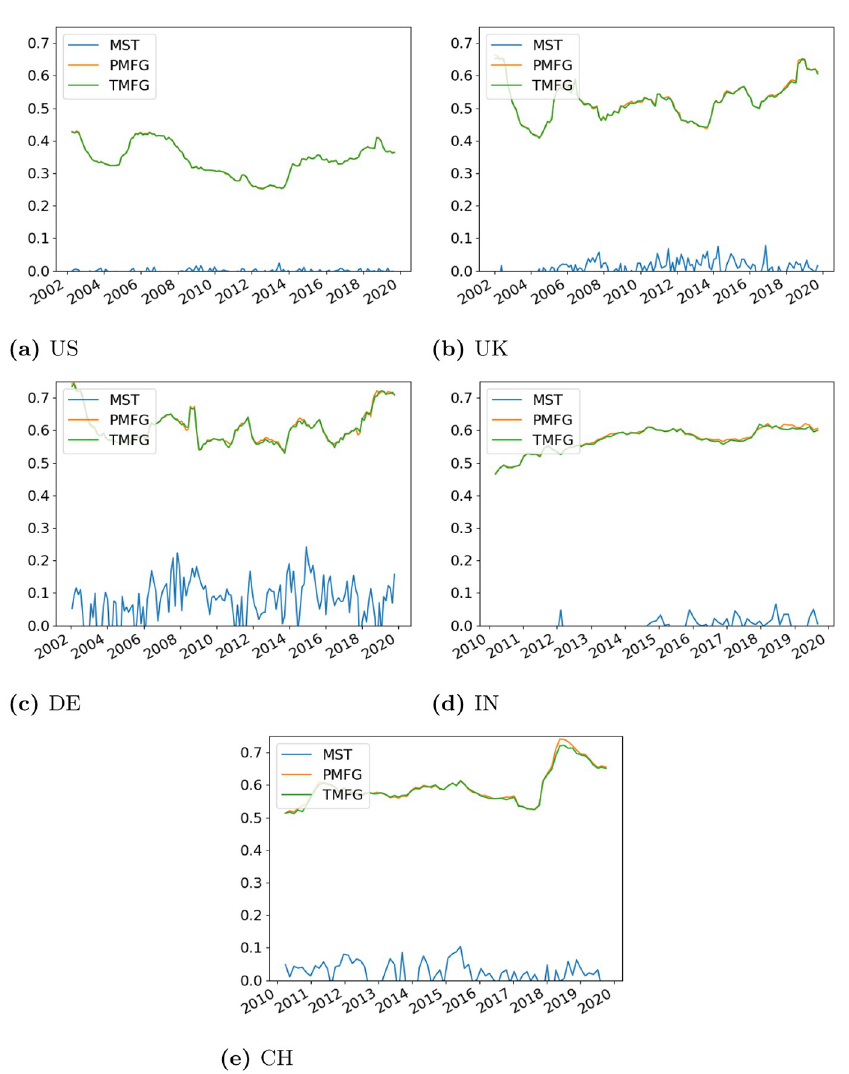
Fig 9. Edge agreement between the full and filtered networks over the time period of the dataset. (a) US, (b) UK, (c) DE, (d) IN, (e) CH.